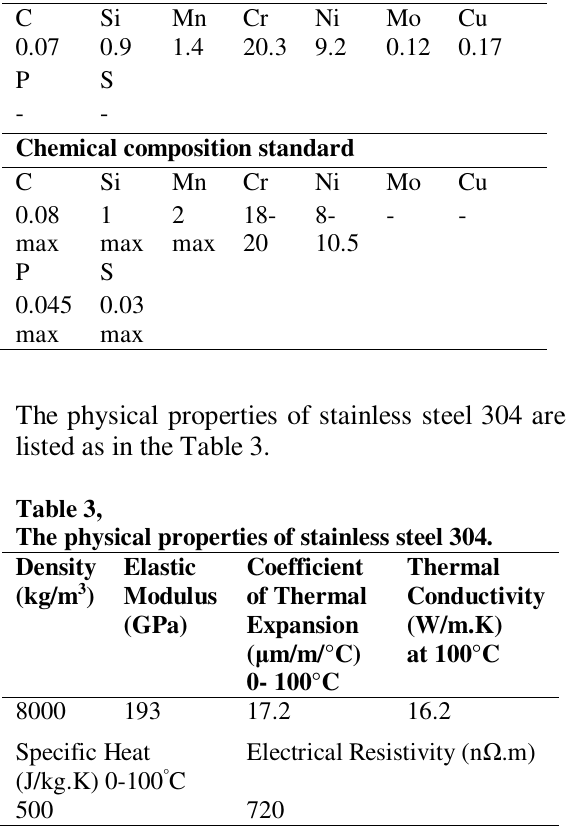
W: is the weight of the workpiece